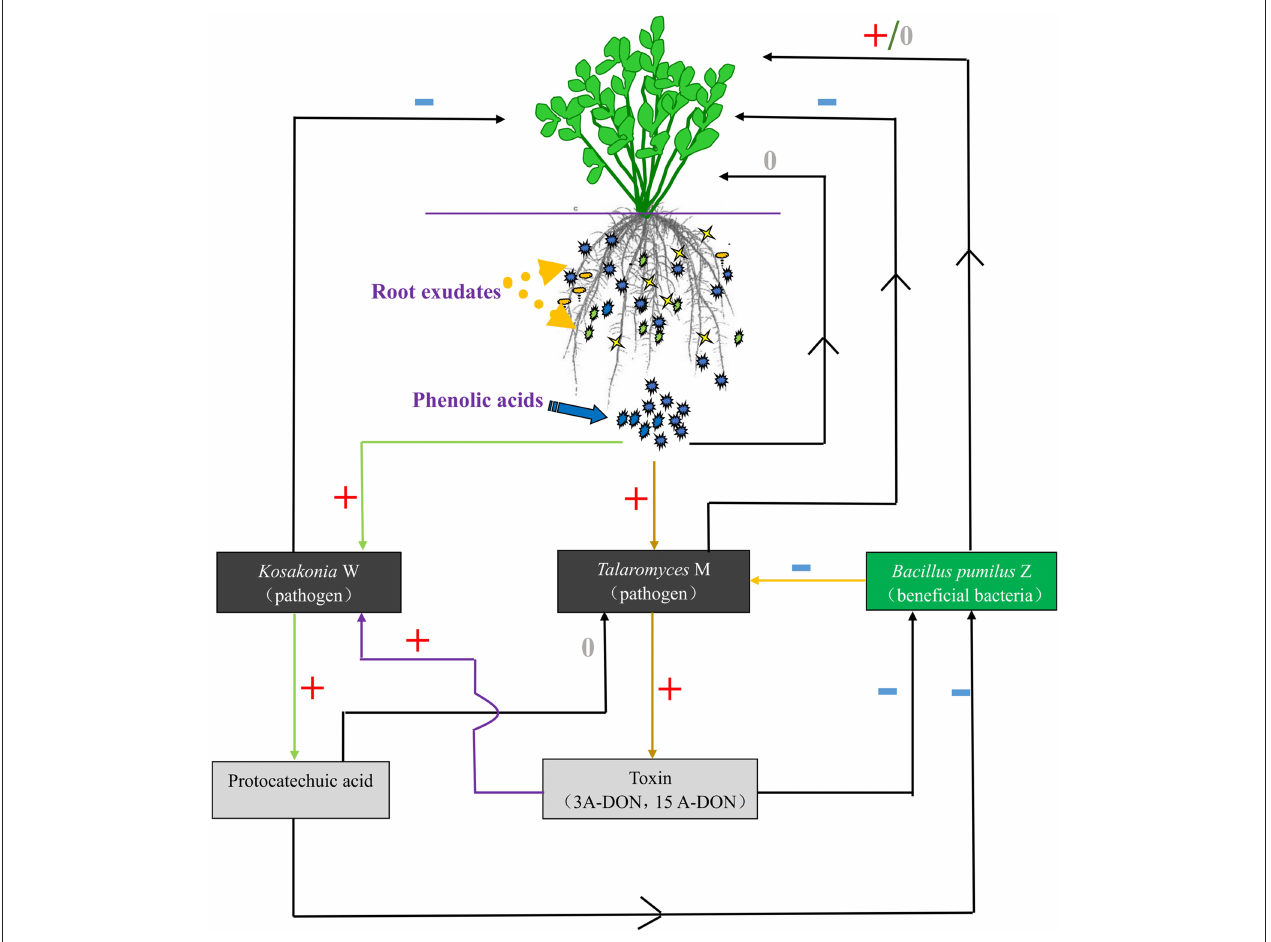
FIGURE 10 | The communication between plants and microorganisms. + , Positive effect; − , negative effect; 0, no